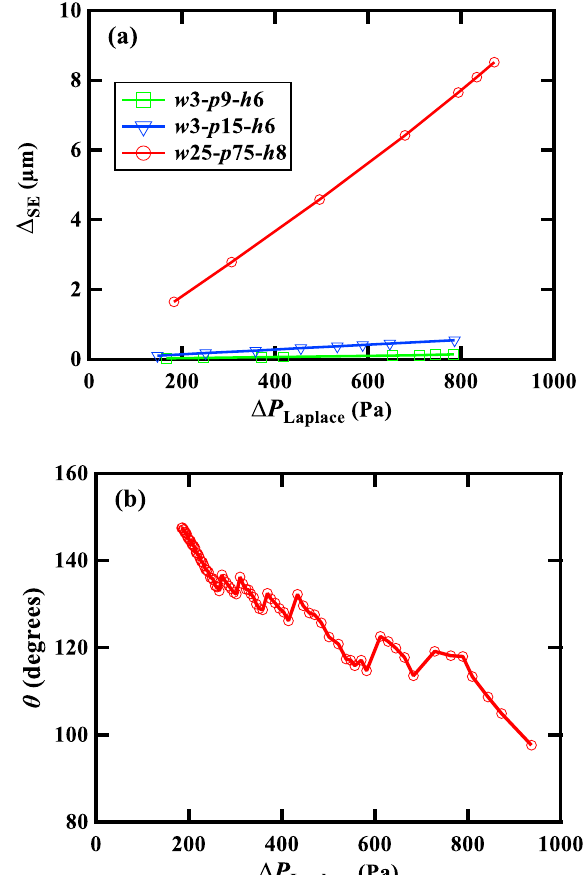
Figure 8. ( a ) Deflection of the droplet bottom meniscus vs. Laplace pressure ( (cid:31) SE − (cid:31) P Laplace curve) numerically obtained in the SE model and ( b ) experimentally obtained CA vs. Laplace pressure ( θ − � P Laplace curve) for the w 25- p 75- h 8 surface.